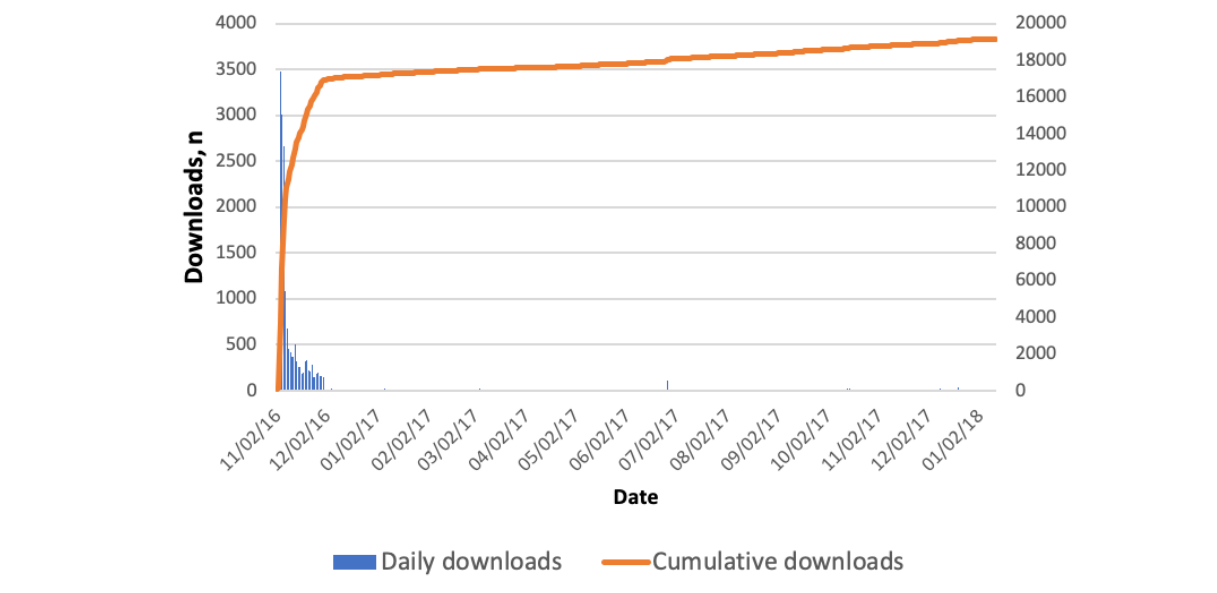
Figure 1. Trends in the number of